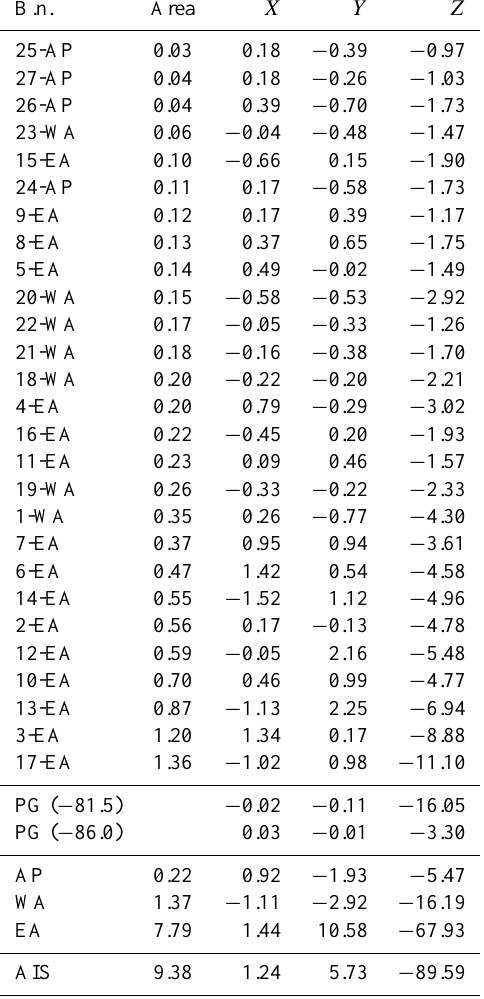
Table 1. Degree-1 sensitivity kernel for Antarctica. The first col- umn indicates the basin number (or region), the second its area, and the other three columns indicate the variation in Gt due to 1mm of variation in the geocenter coordinates X , Y and Z (in Gtmm − 1 ). Two spherical caps of the dimension of the polar gaps (PG) and three macro regions, Antarctic Peninsula (AP), West (WA) and East Antarctica (EA), are also computed.